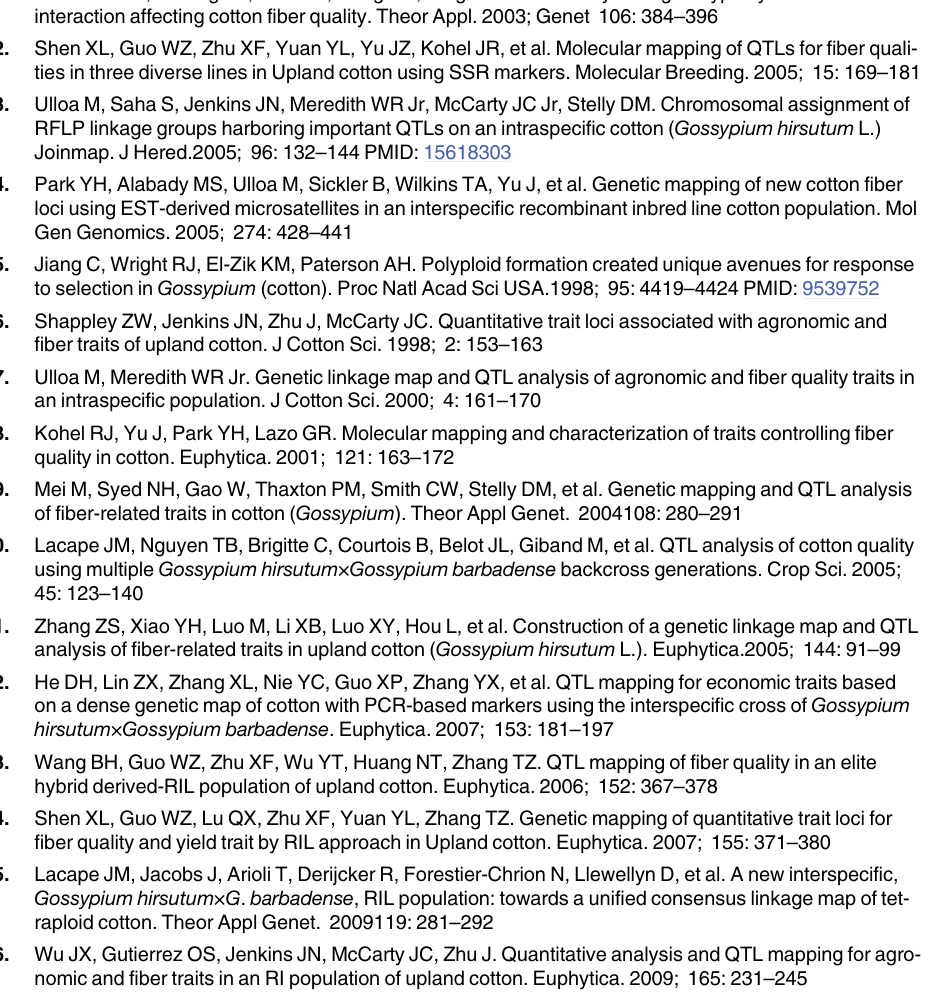
S5 Table. Mapping of the QTL that only identified in one environment.